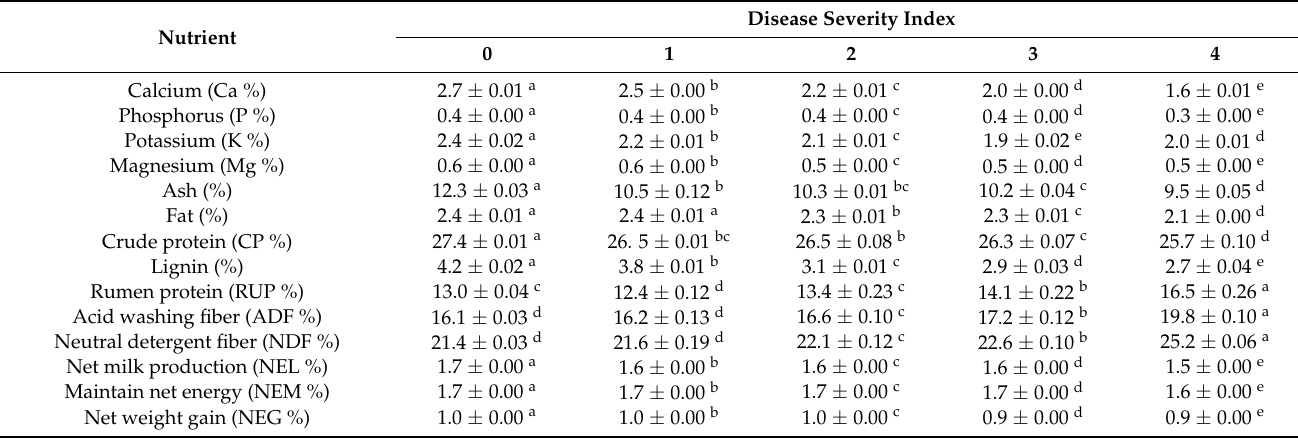
Table 4. Nutrients in alfalfa leaves with different severity